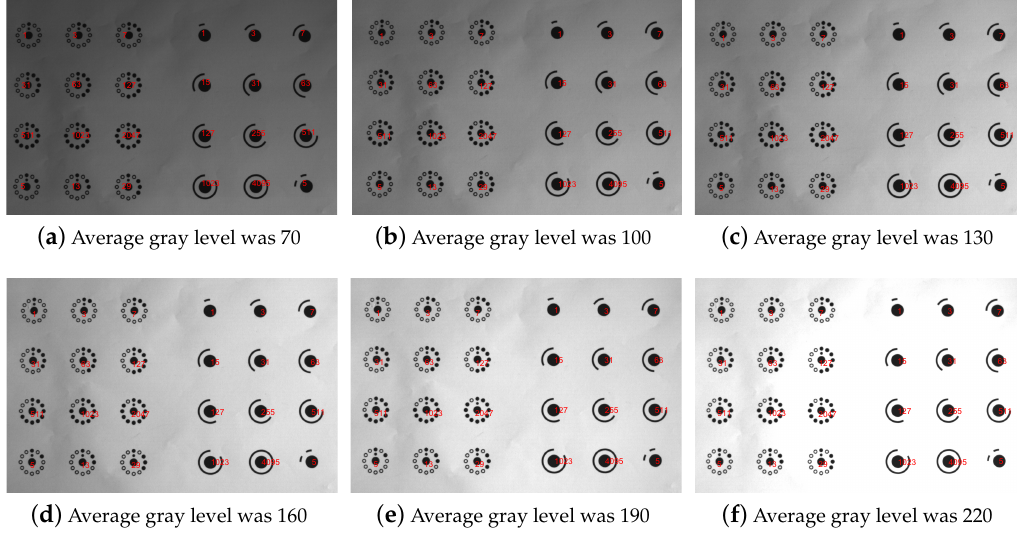
Figure 4. A comparative experiment on light.